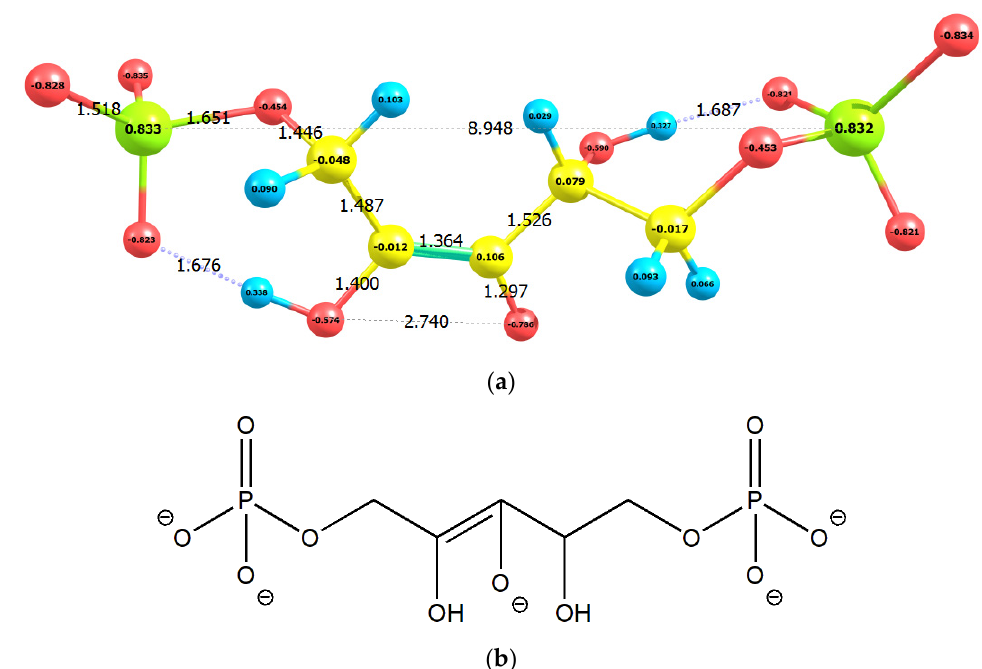
Figure A7. ( a ) The calculated geometric and electronic structure of 1/2-ene(mono/di)olate (2,3-enediolate); Q = − 5, M = 1, E 0 = − 46,424.27 eV, G 0 = − 46,421.25 eV. Hessian has negative frequencies: − 28.34 (cm − 1 ). ( b ) The scheme of (Z)-2,4-dihydroxy-3-oxidopent-2-ene-1,5-diyl diphosphate.